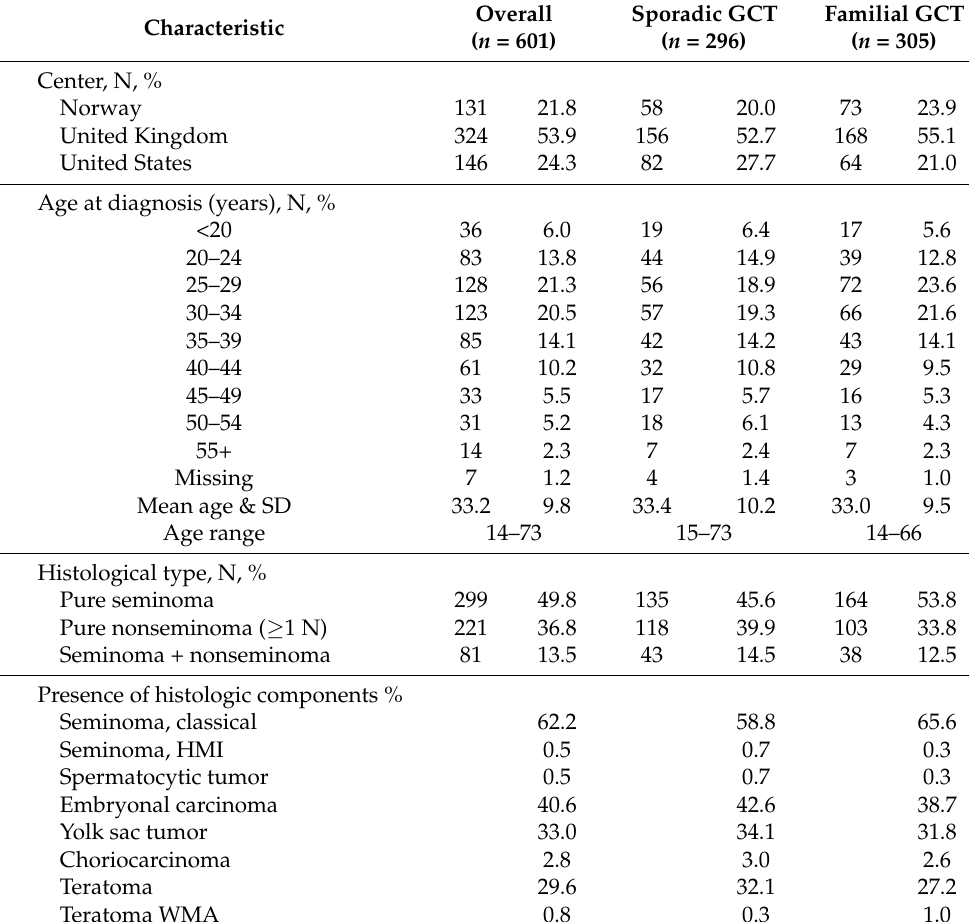
Table 1. Demographic characteristics and histological subtypes of 601 sporadic and familial testicular germ cell